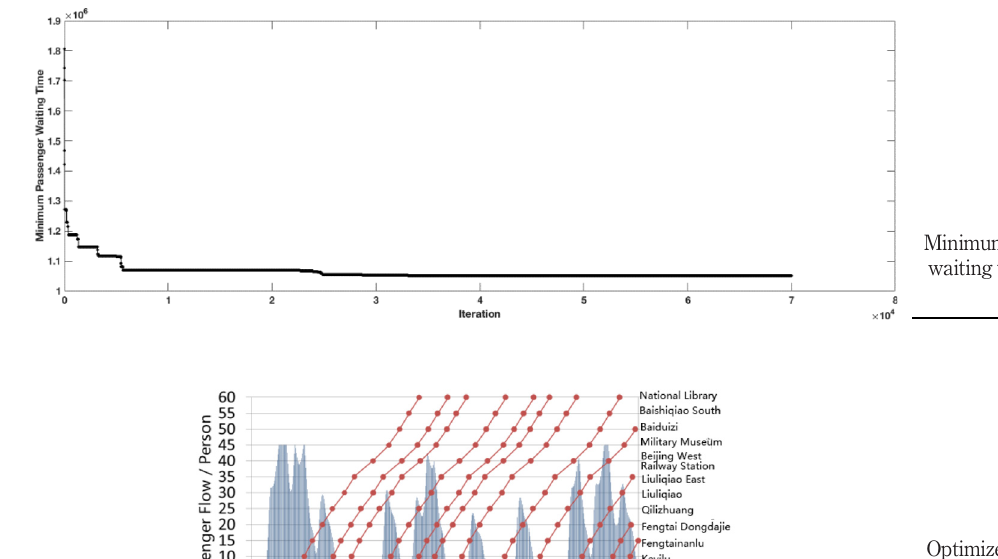
Figure 6. Optimized